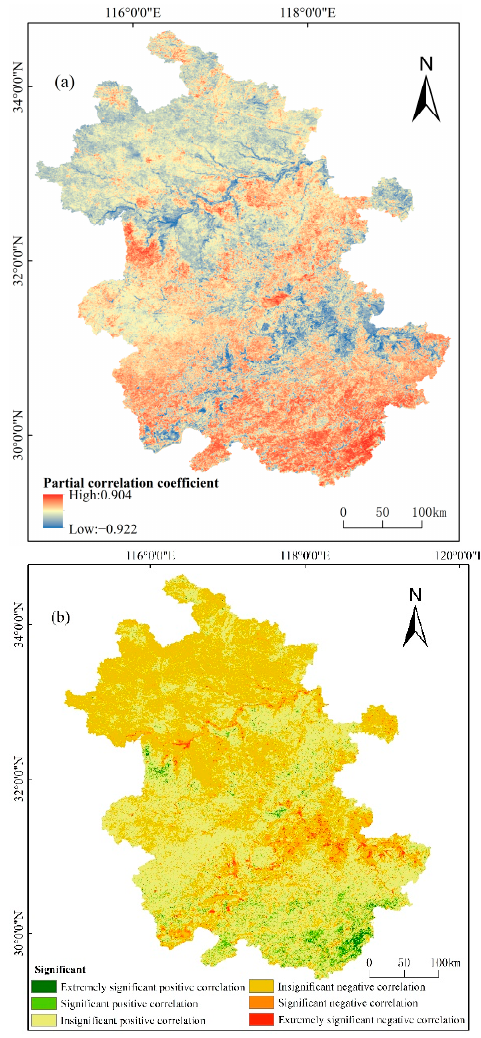
Figure 10. Partial correlation coefficient between NDVI and precipitation and distribution of signifi- cance level: ( a ) partial correlation coefficient between NDVI and precipitation, its value ranged from − 0.873 to 0.914; ( b ) distribution of significance level, divided into 6 grades by significance test using t statistic: extremely significant positive correlation, significant positive correlation, insignifi- cant positive correlation, insignificant negative correlation, significant negative correlation, and ex- tremely significant negative correlation.